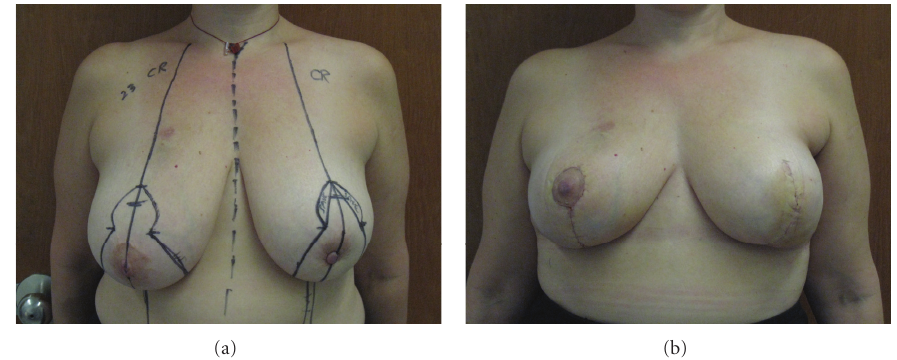
Figure 3: (a) Preoperative markings for Wise pattern oncoplastic breast reduction with planned excision of the left nipple areola complex. (b) Two-week postoperative result showing bilateral oncoplastic breast reductions with excision of left nipple-areola complex. Patient will then have nipple-areola reconstruction after completion of